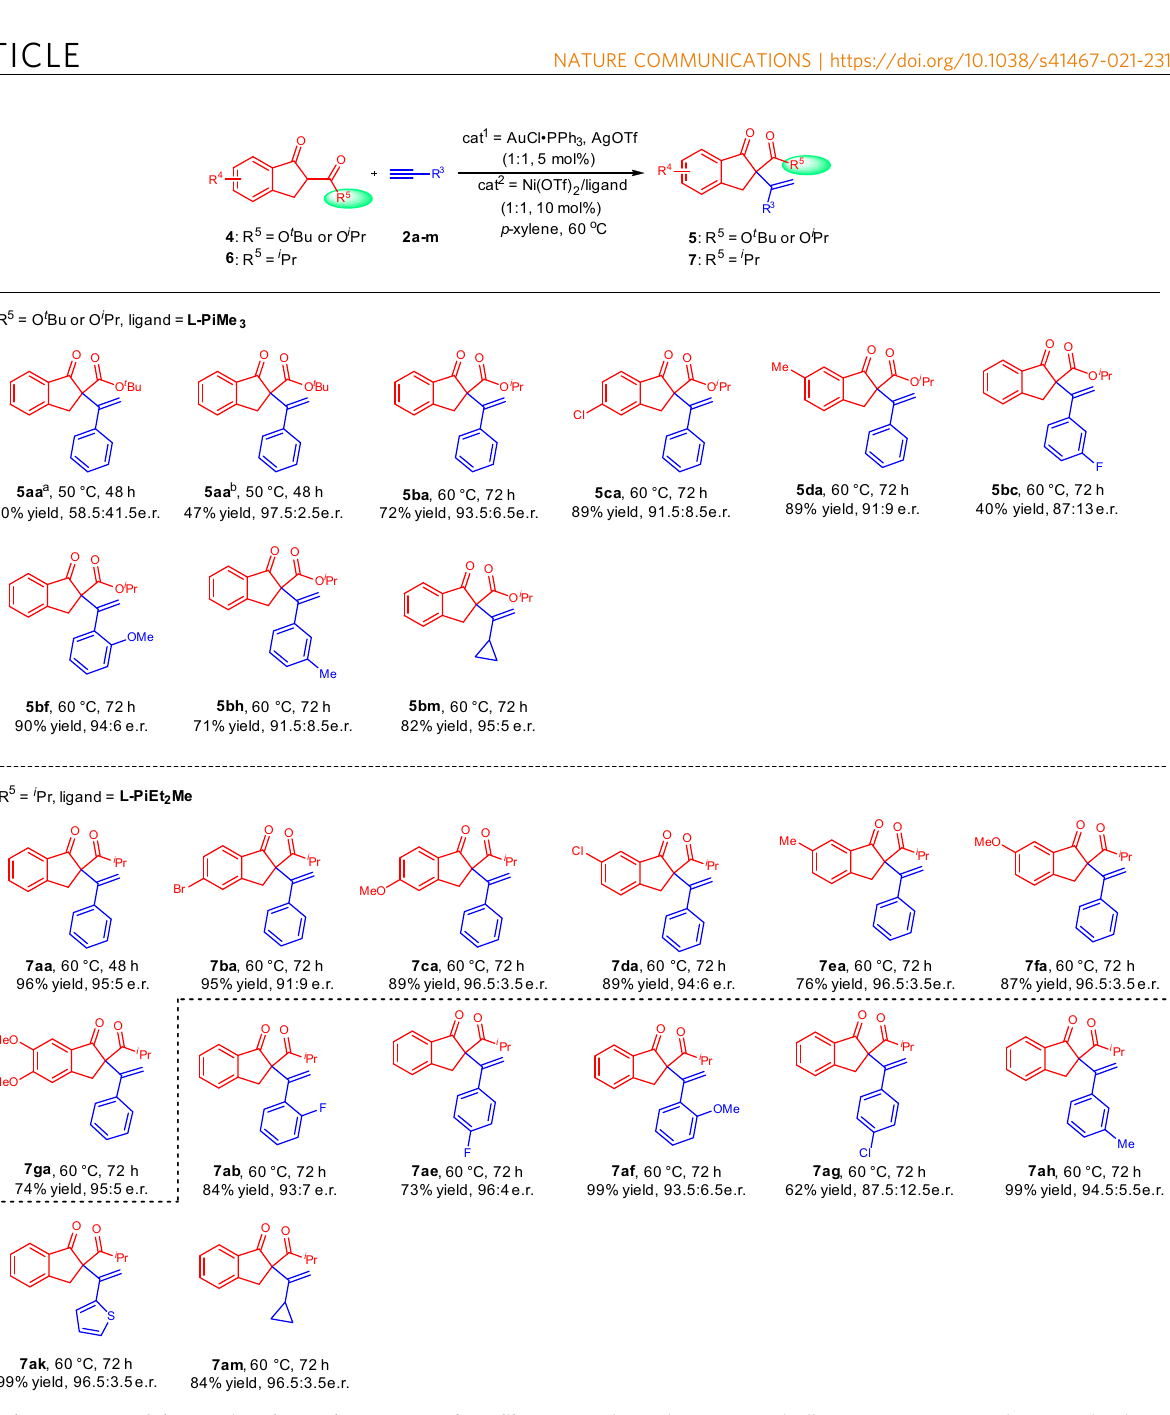
Fig. 3 Substrate scope of the reaction about β -ketoesters and 1,3-diketones. Unless otherwise noted, all reactions were carried out, AuCl ∙ PPh 3 /AgOTf (1:1, 5 mol%), Ni(OTf) 2 /ligand (1:1, 10 mol%), 4 or 6 (0.10 mmol) and 2 (2.0 equiv) in p -xylene (1.0 mL) at 60 °C for 48 – 72 h. Isolated yields. The e.r. values were determined by HPLC analysis on chiral column. a In(OTf) 3 / L-PiEt 2 Me = 1:1.2, 10 mol%, p -xylene (1.5 mL), 24 h. b L-PiMe 2 was used as